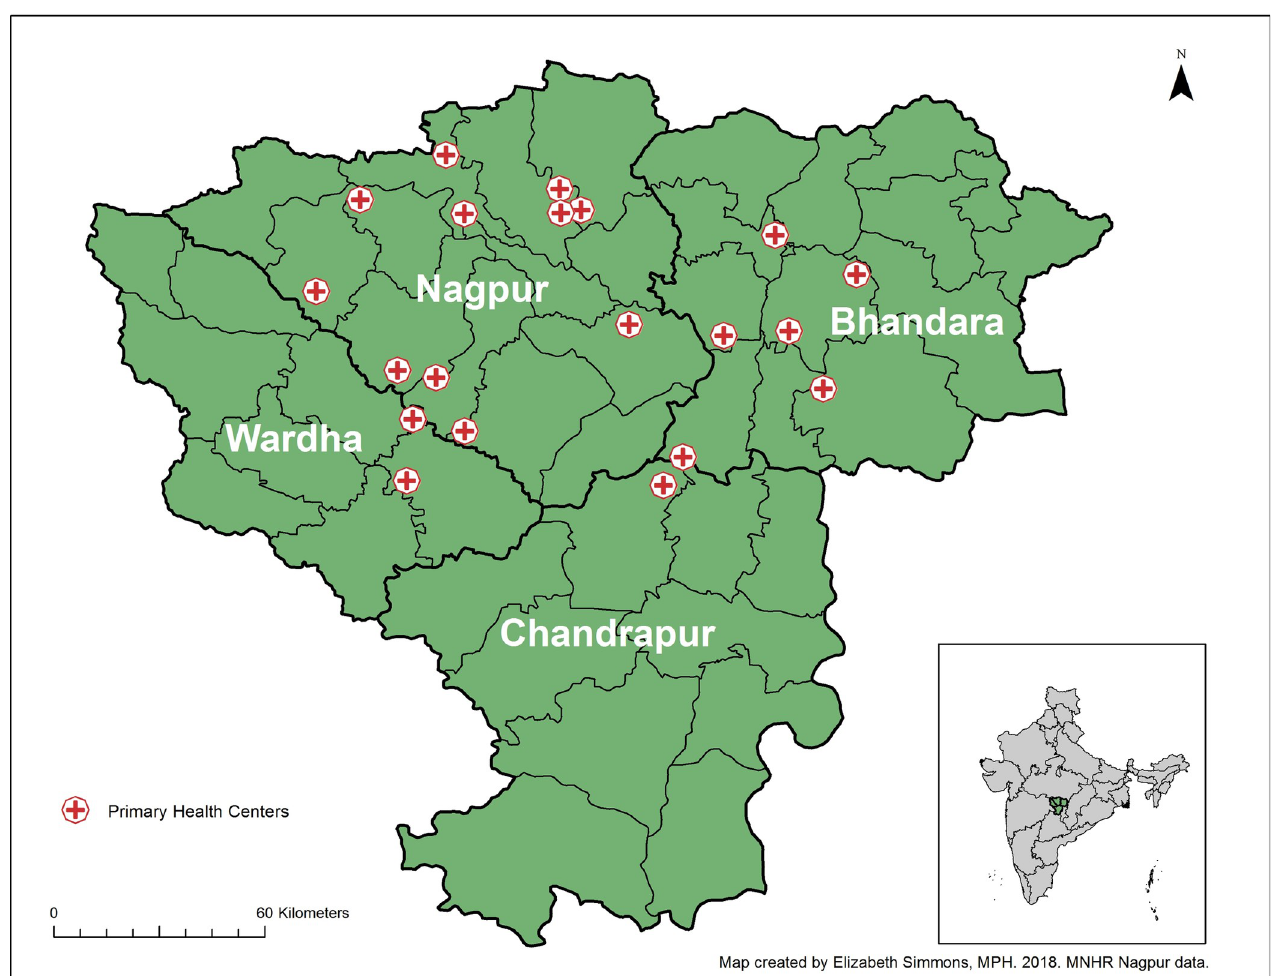
Fig 1. Map of 20 primary health centers in Nagpur